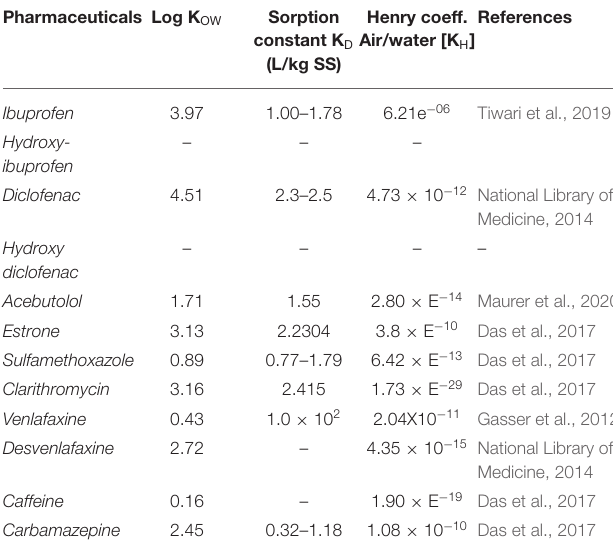
TABLE 5 | Physiochemical properties of studied